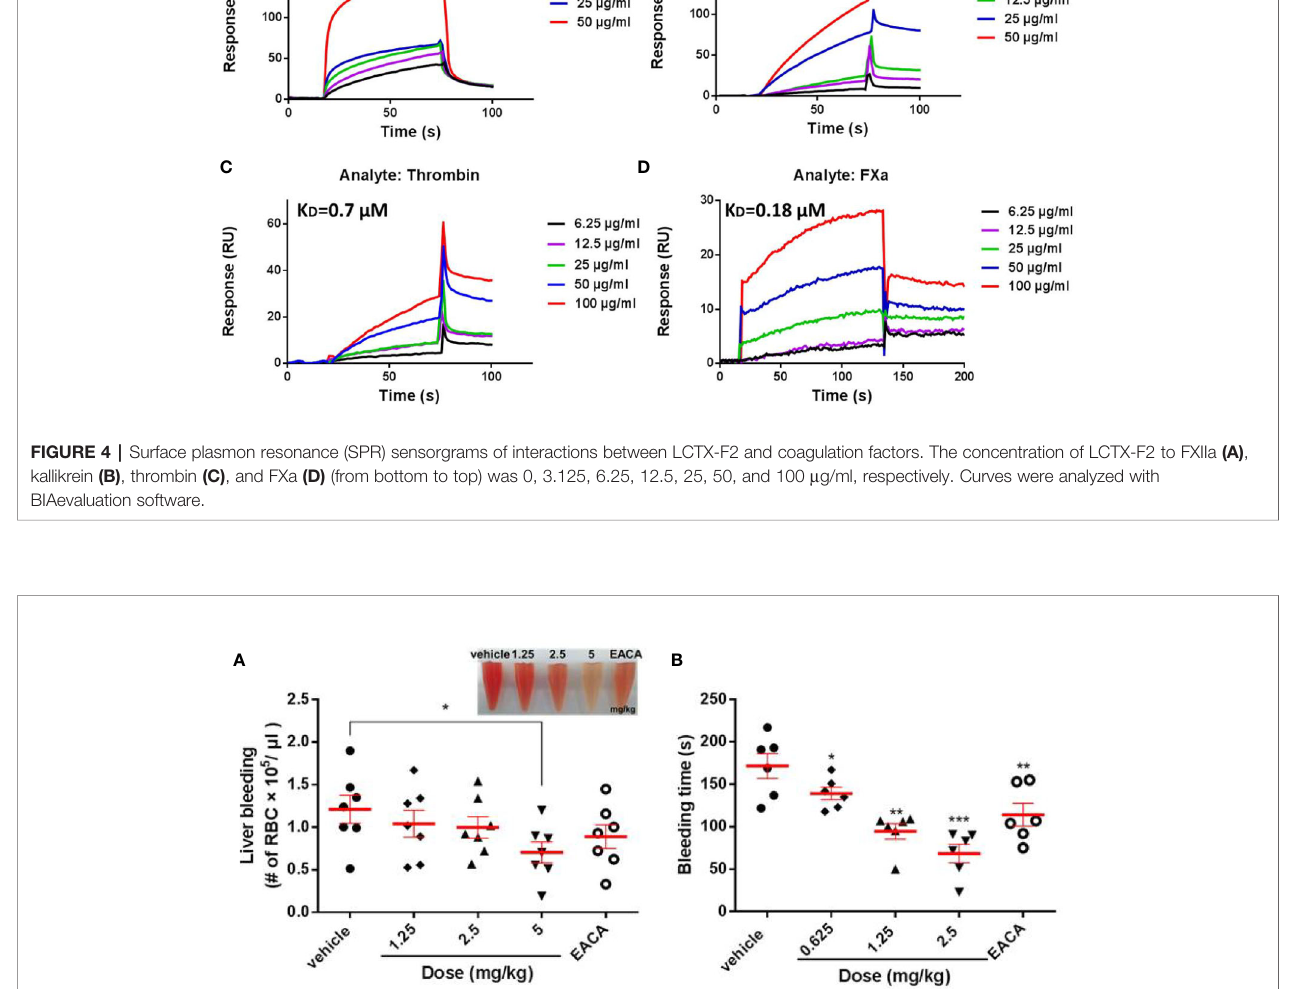
FIGURE 5 | The effect of LCTX-F2 on bleeding model in vivo . The hemostatic effect of LCTX-F2 (0.65, 1.25, and 2.5 mg/kg) and 5 mg/kg EACA were measured in liver bleeding (A) and tail bleeding (B) mouse models. (A) The number of red blood cells (RBCs) was counted to determine the effect of LCTX-F2 and EACA ( n = 7). RBCs are shown in (A) . (B) Bleeding time was determined as the time from tail transection to the moment the blood fl ow stopped for 120 s ( n = 6). Data are presented as means ± SD. * P < 0.05, ** P < 0.01, *** P < 0.001 compared with vehicle as determined by the two-sample Student ’ s t